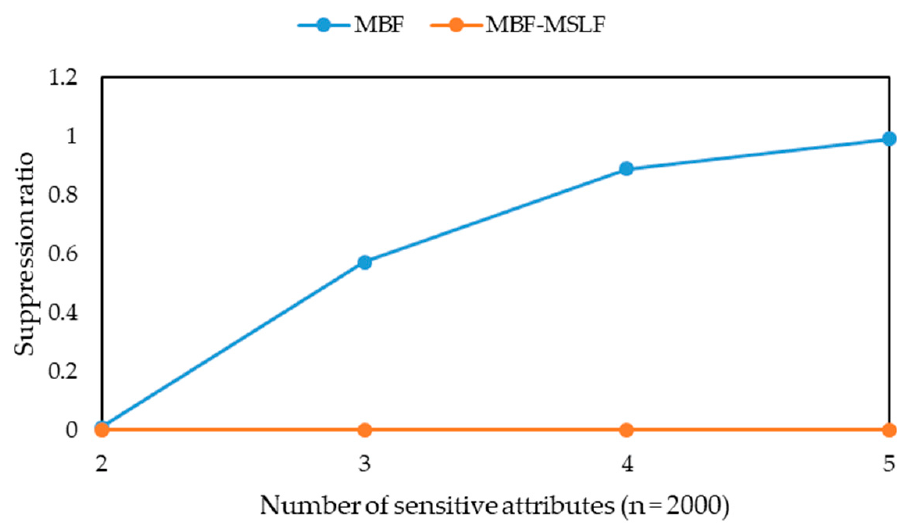
Figure 6. The suppression ratio of MBF and MBF-MSLF with different sensitive attribute numbers ( n = 2000).